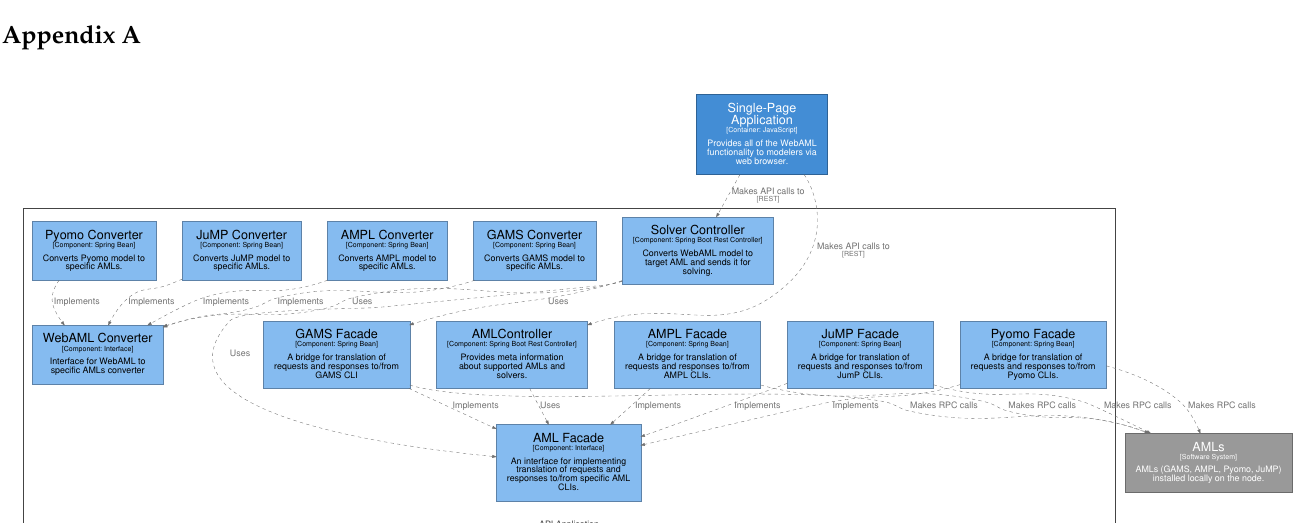
Figure A1. Components of the WebAML Optimization System in C4 architectural model notation. WebAML Converter and AML Facade interfaces support additional new AMLs.